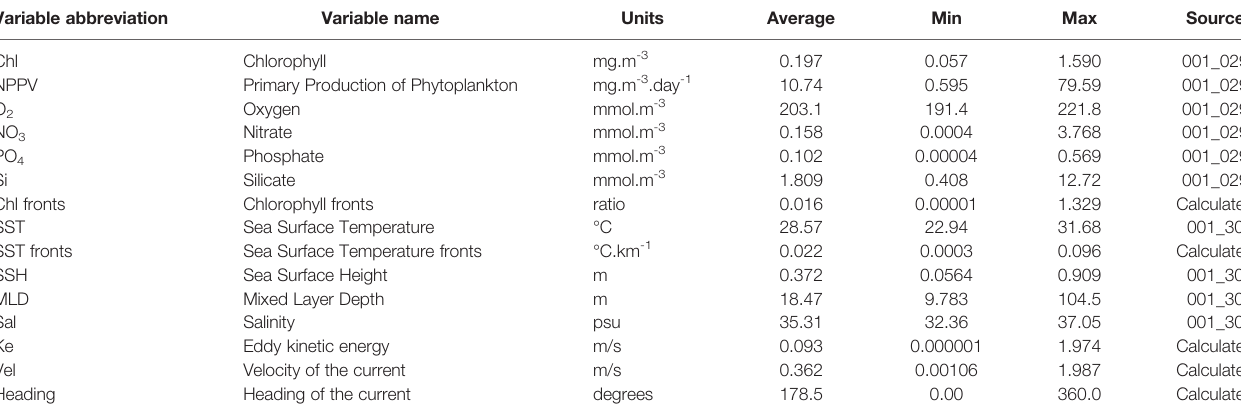
TABLE 1 | Summary of the predictor environmental variables used in the